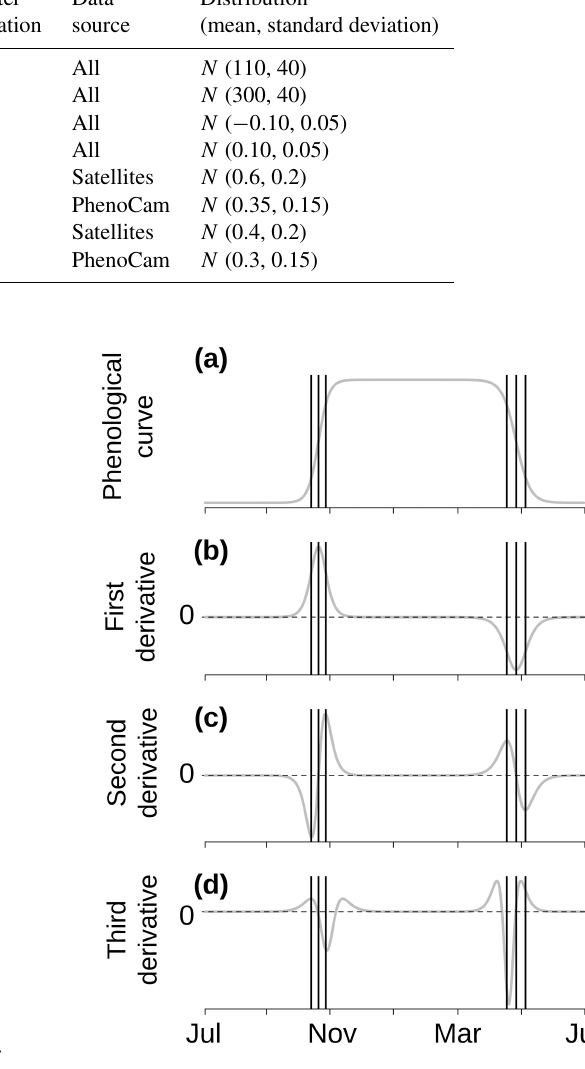
Table 2. Parameter priors. “Satellites” refers to all GOES, MODIS NDVI, and MODIS EVI. The priors on when the middle of spring and autumn occurred were set as the day of year (DOY). Normal distribution is abbreviated with N . Parameter Parameter Data Distribution name abbreviation source